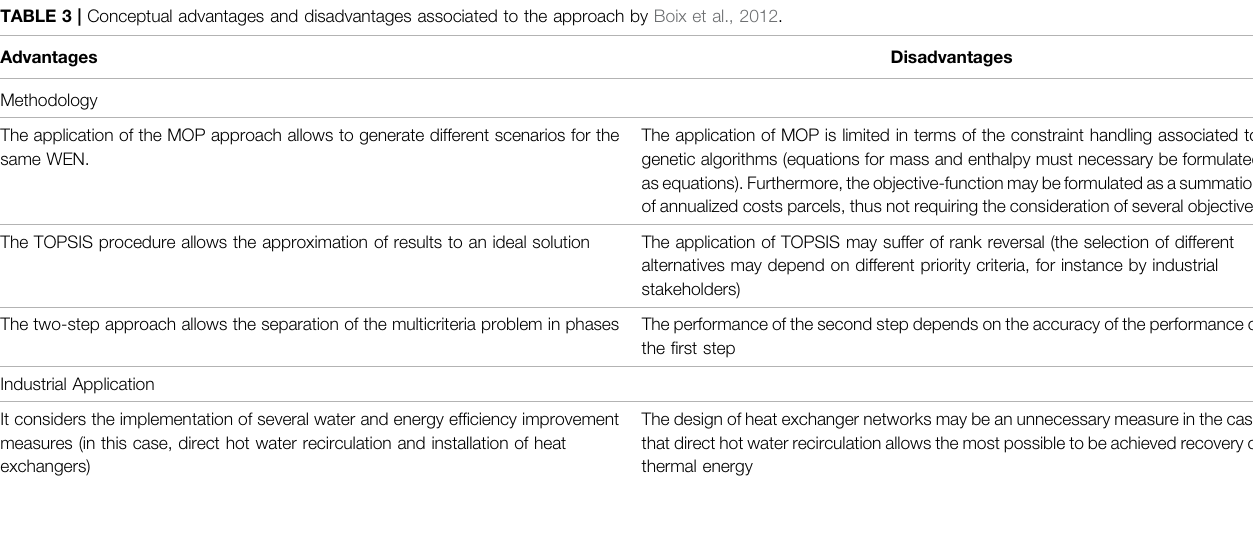
TABLE 3 | Conceptual advantages and disadvantages associated to the approach by Boix et al.,